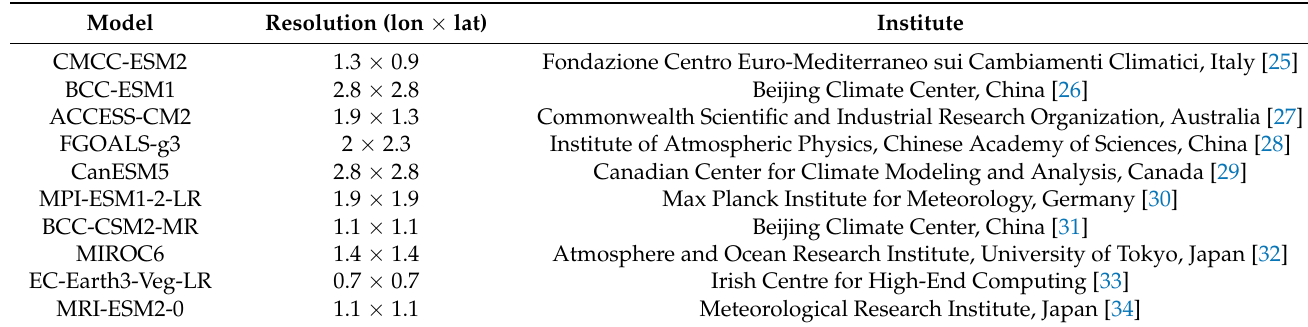
Table 2. List of GCMs evaluated in the